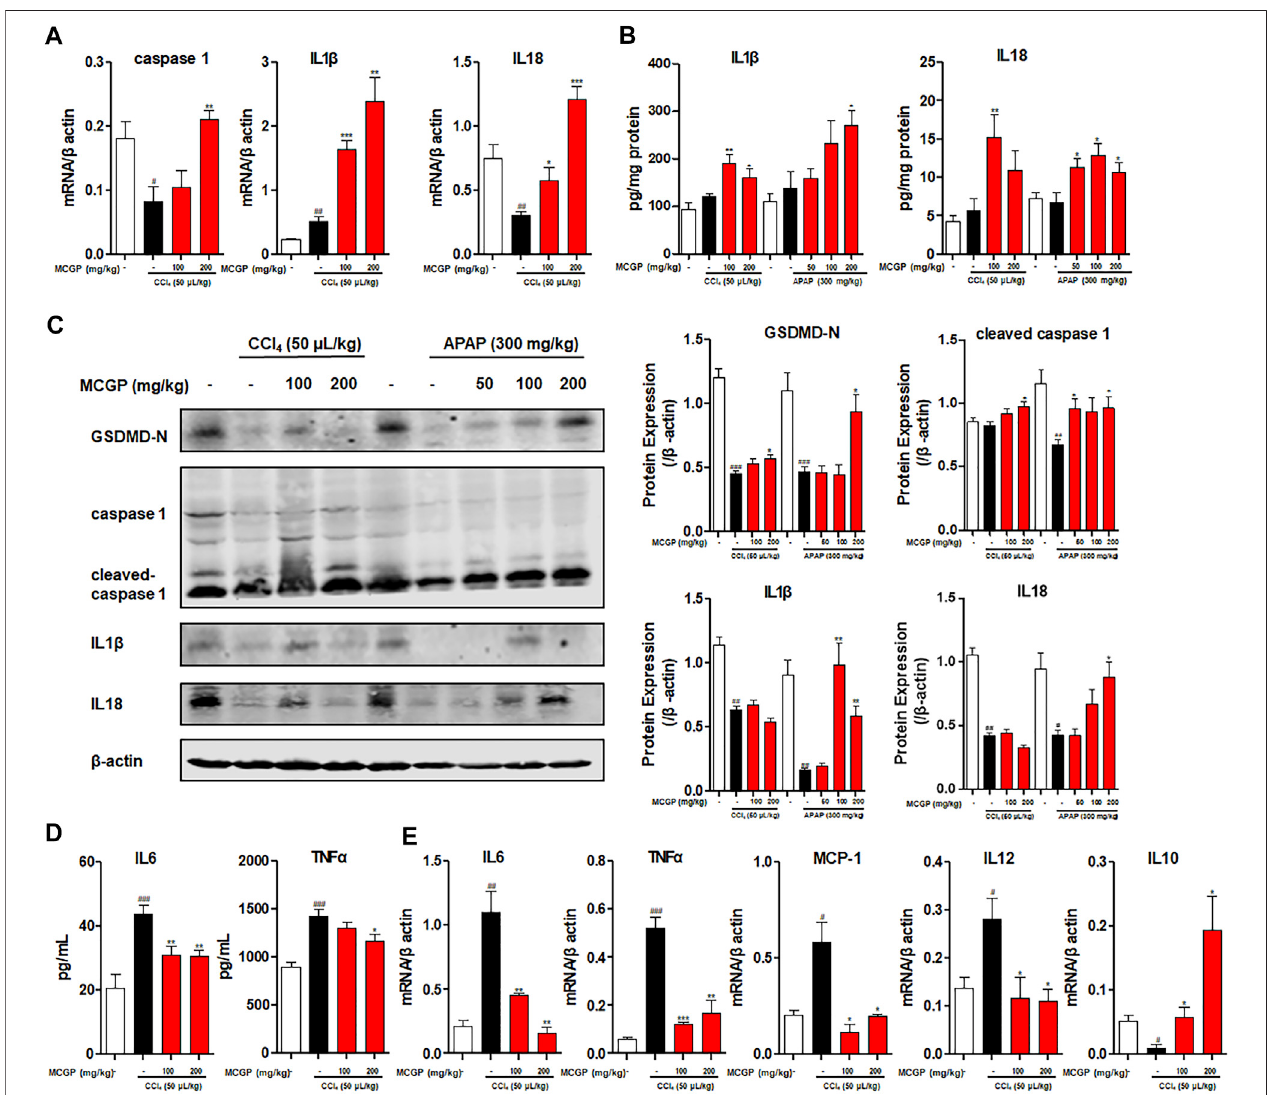
FIGURE 8 | MCGP promoted IL18 secretion and inhibited in fl ammation in APAP-/CCl 4 -intoxicated mice livers. (A) Transcription level of caspase 1, IL1 β , and IL18 ofeachgroupinCCl 4 -intoxicatedmice. (B) ThelivercontentofIL1 β andIL18ofeachgroupinAPAP-orCCl 4 -intoxicatedmice. (C) TheproteinexpressionofGSDMD-N, caspase1,cleaved-caspase1,IL1 β ,andIL18inlivertissuefromtheAPAPorCCl 4 groups.The β -actinwasusedasaninvariantcontrolforequalloading,followedbythe integrityopticaldensityanalysesofeachblot. (D) TheserumlevelofIL6andTNF α ofeachgroupinCCl 4 -intoxicatedmice. (E) TranscriptionlevelofIL6,TNF α ,MCP- 1, IL12, and IL10 of each group in CCl 4 -intoxicated mice. Data were presented as the mean ± SEM (n = 3). # p < 0.05, ## p < 0.01, ### p < 0.001 vs control, * p < 0.05, ** p < 0.01, *** p < 0.001 vs